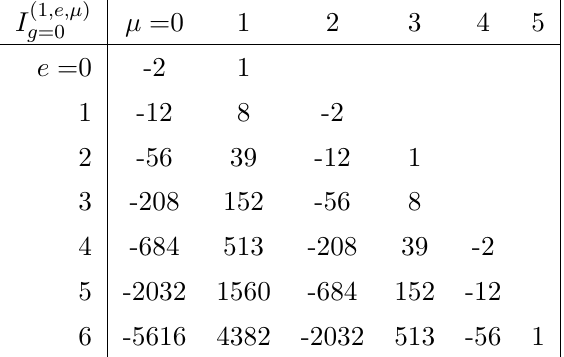
Table 10 . Unrefined BPS invariants of the massive M-string at base degree b = 1 and genus g = 0. For b = 2, we find spin representations that occur subleading for smaller values of c 0 : N (2 , 7 , 7) j − j